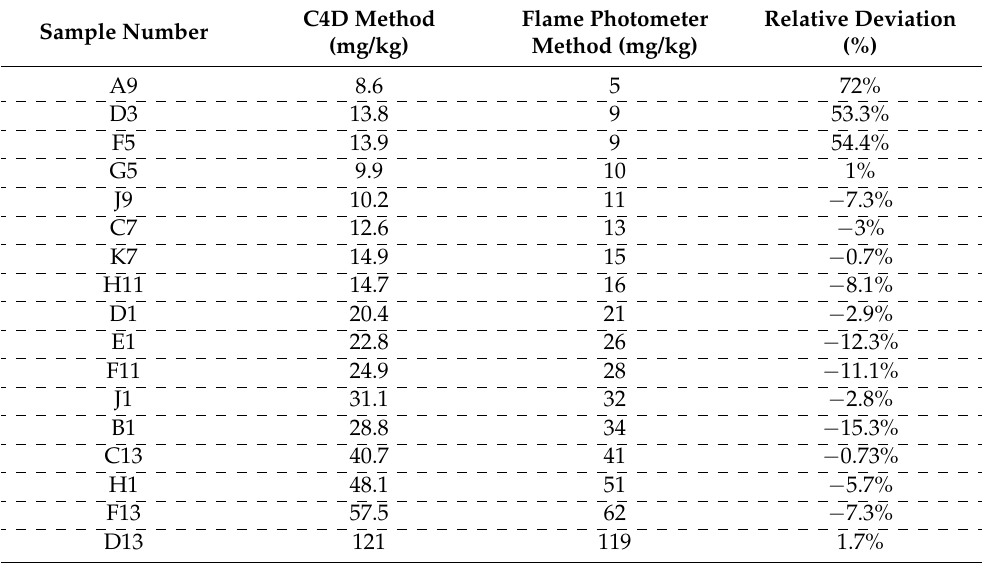
Table 2. Comparison of detection results between the C4D method and flame photometer